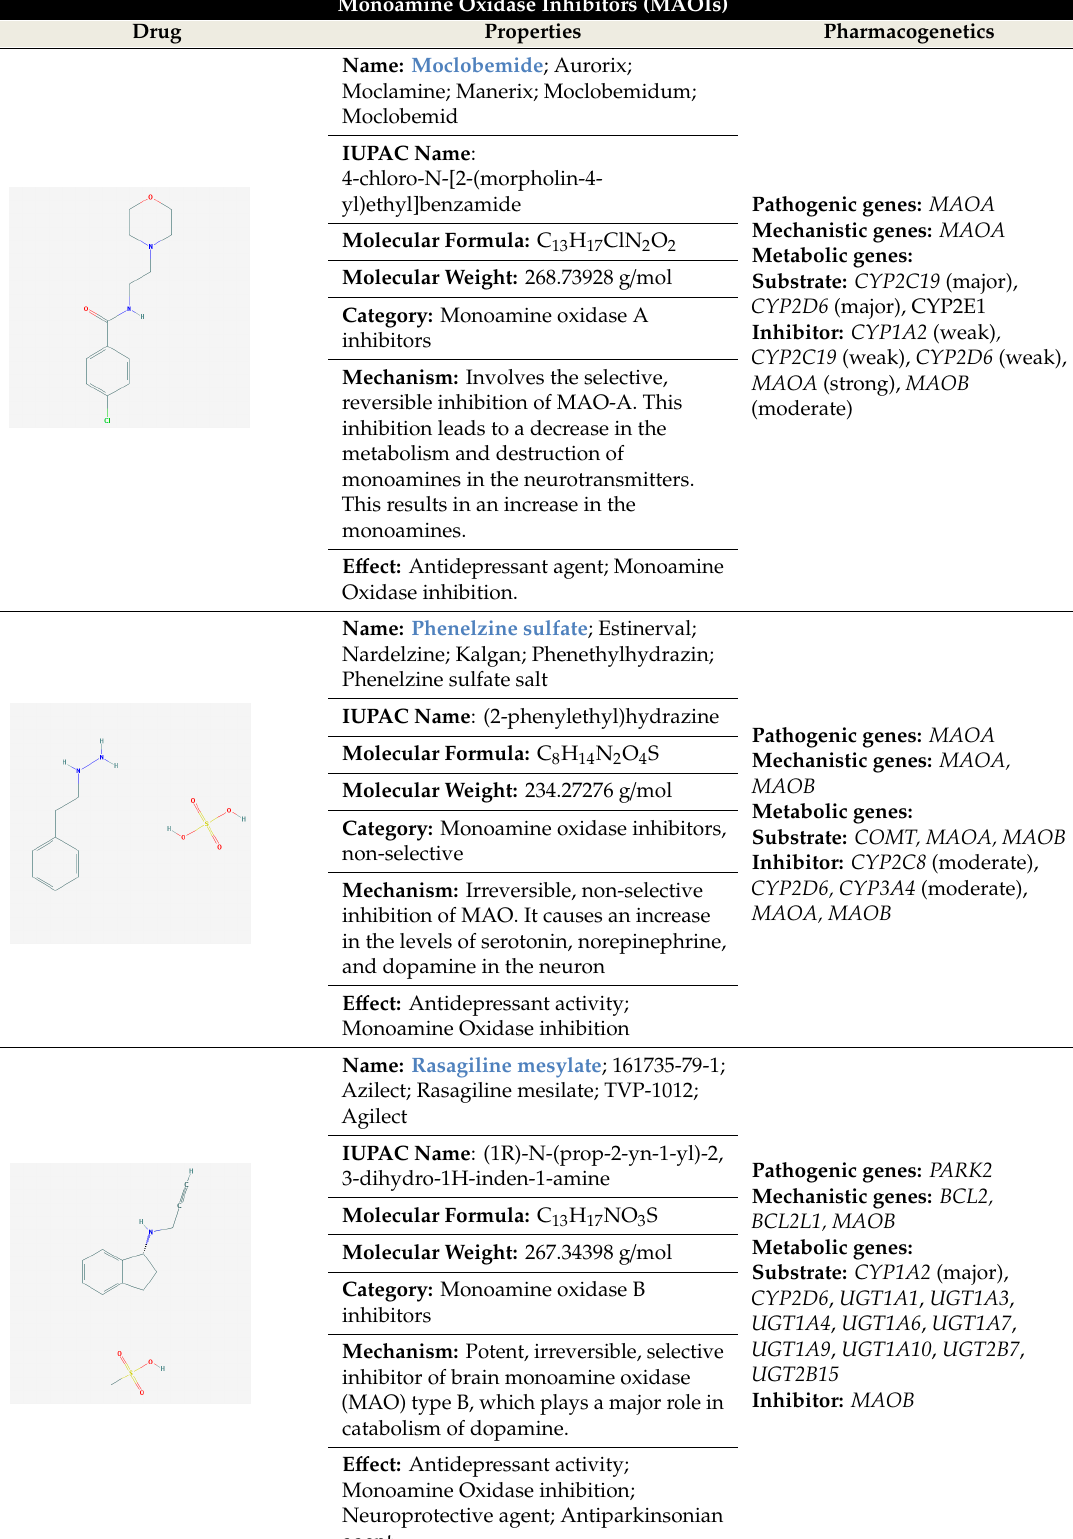
Table 4. Pharmacological profile and pharmacogenetics of selected antidepressants.